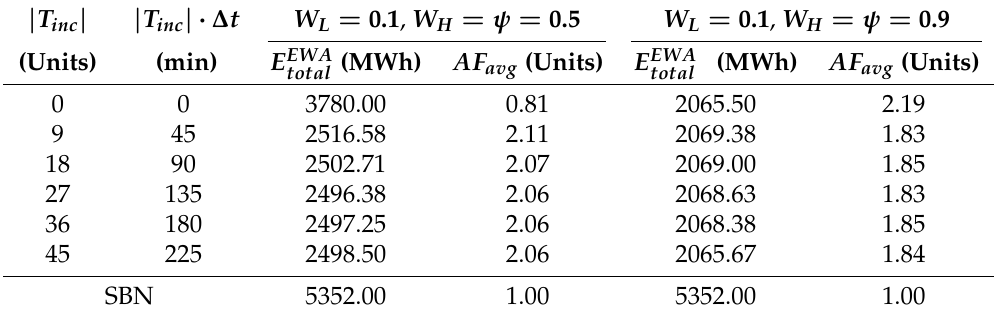
Table 2. Energy consumption E EWA over a day and AF avg with AF sleep = 0.5 and χ = 0.5 h/cycle after total 14 days vs. the length of T inc for traffic with scaling factor